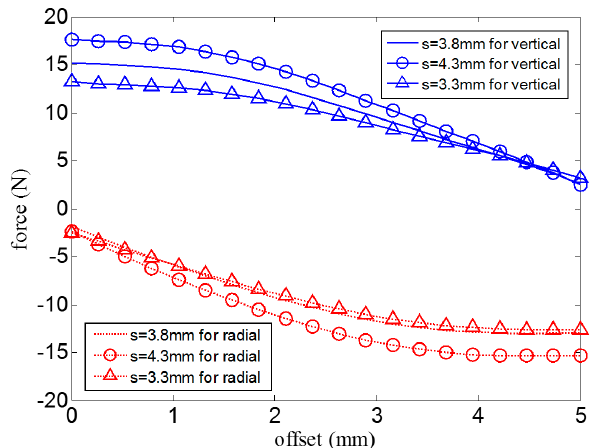
Figure 9. The magnetic force of a passive magnetic unit.